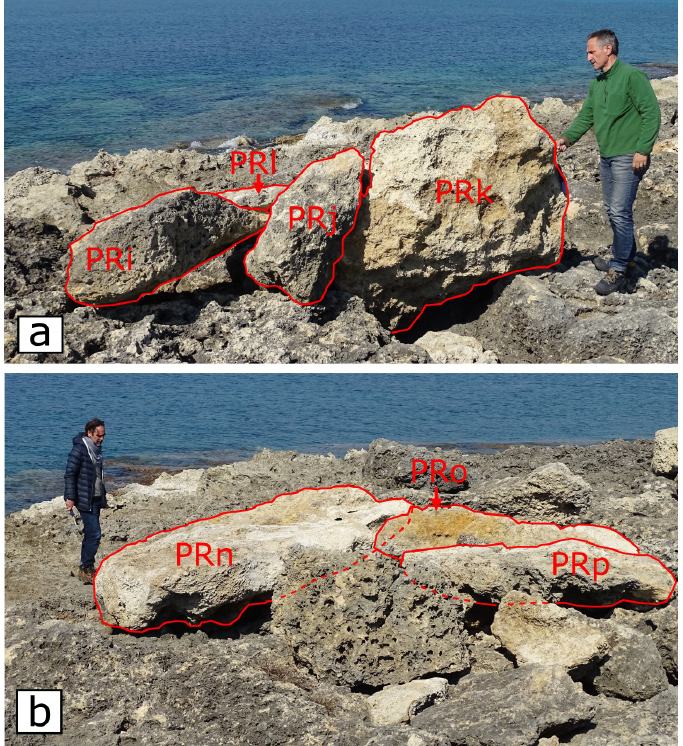
Figure 4. Two main boulder clusters of Punta Prosciutto headland: ( a ) Four imbricated boulders arranged in the SW-NE direction. ( b ) Group of closely spaced boulders that includes the largest (PRn) of this stretch of